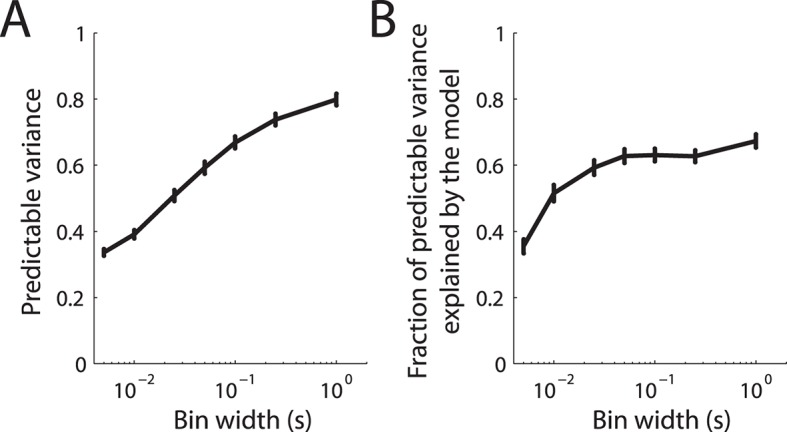
Prediction accuracy of fitted LNP model.(A) Predictable variance in the recorded cortical spike trains as a function of bin width. The solid line denotes the mean over the cortical population and the error bars denote the standard error of the mean. Due to jitter in the recorded spike trains, the predictable variance decreases for finer bin sizes. (B) Fraction of predictable variance explained by the model as a function of bin width. The solid line denotes the mean over the cortical population and the error bars denote the standard error of the mean.